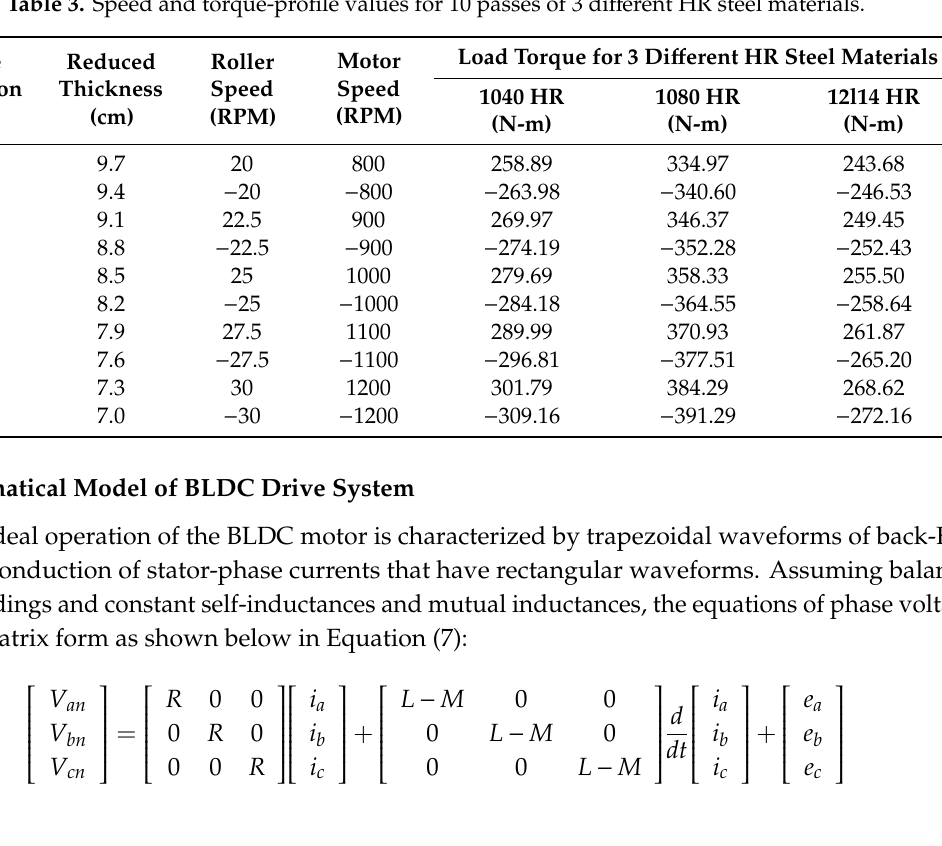
Table 3. Speed and torque-profile values for 10 passes of 3 di ff erent HR steel